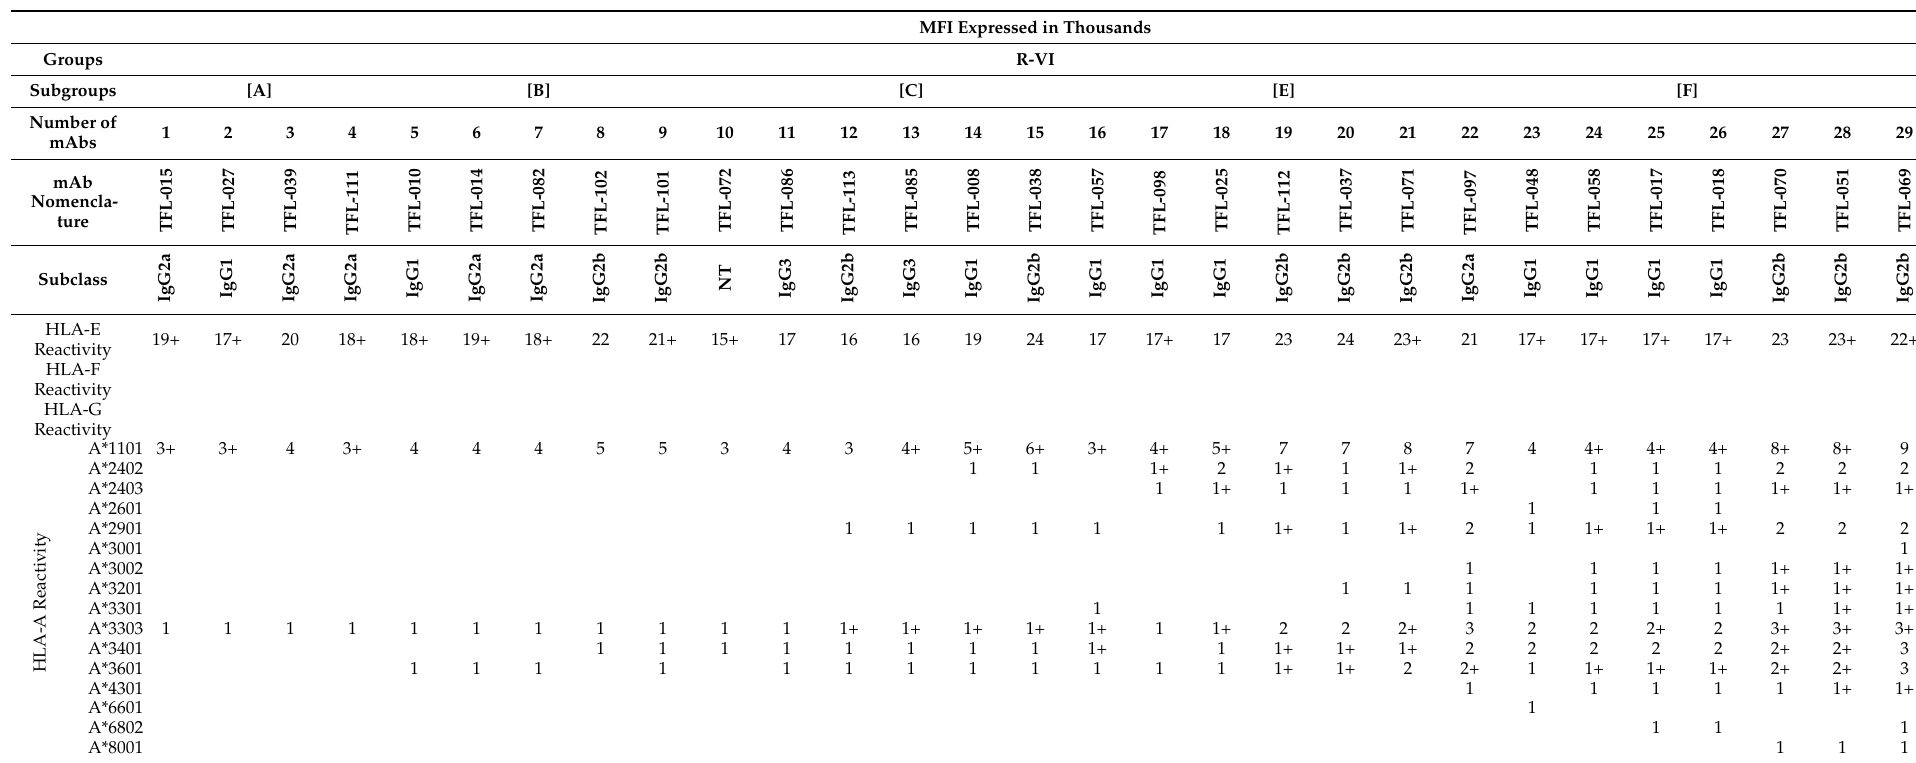
Table 6. Evolving HLA-E R mAbs: HLA-F, HLA-G non-reactive but reactive to HLA-A, HLA-B, and HLA-C